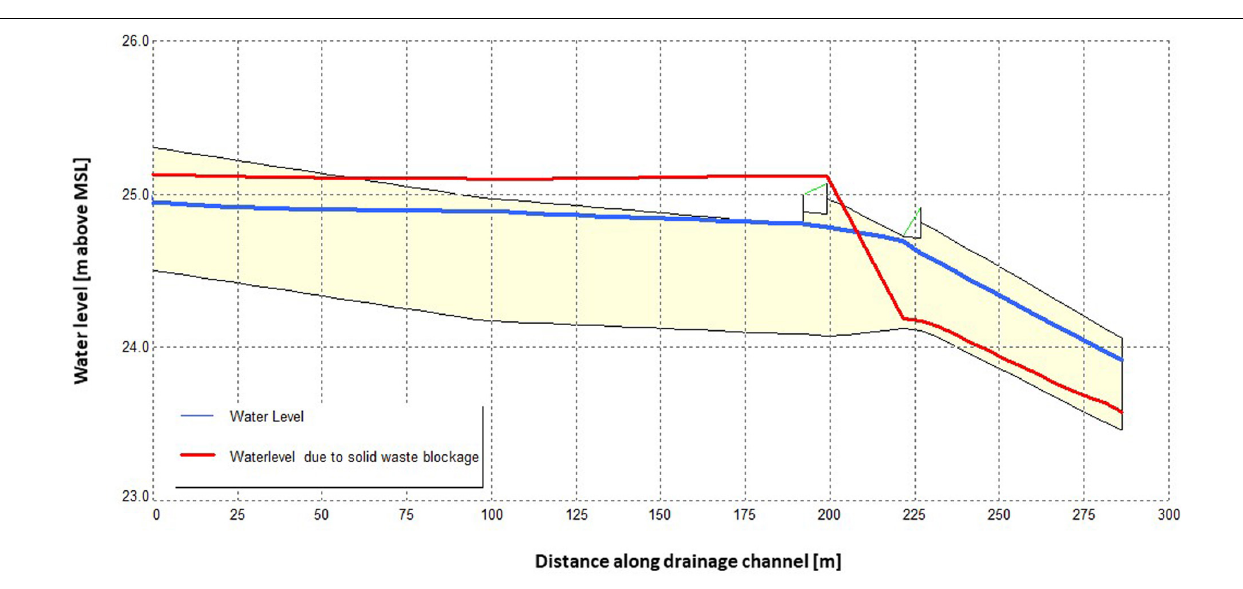
FIGURE 6 | Side view in SOBEK of drainage segment blocked by solid waste (blockage at 225 m). The y-axis shows elevation above DTM datum, and the x-axis shows horizontal distance from the start of the selected side